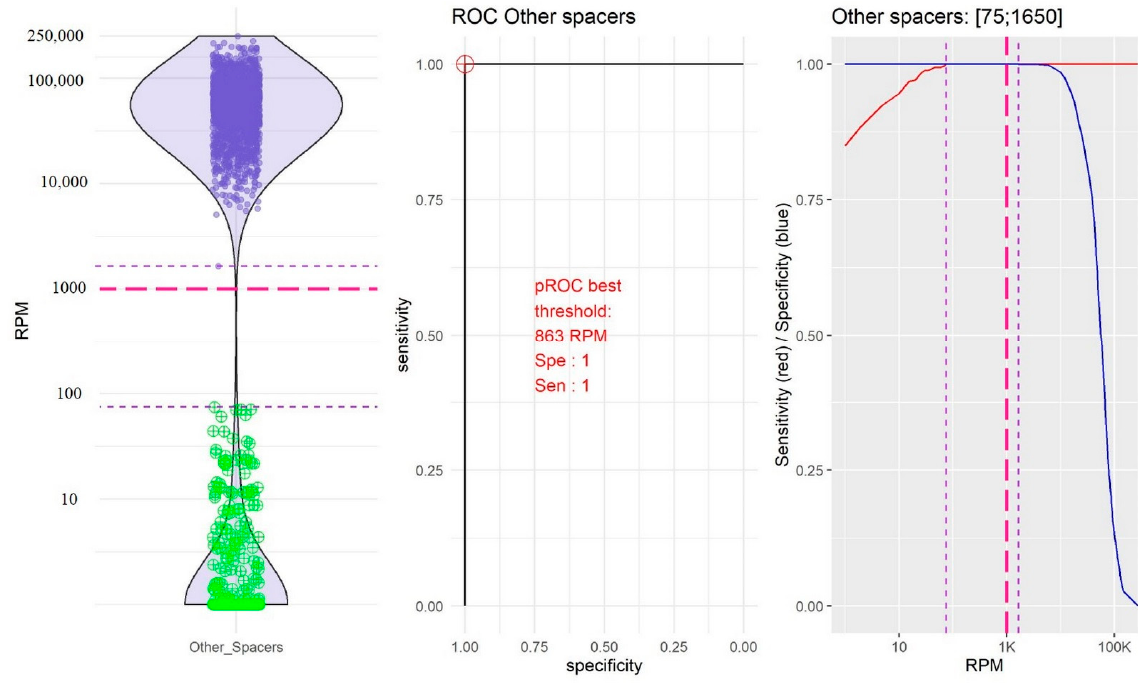
Figure 3. Determination of the reads per million (RPM) threshold for spacers 20, 21, and 31. On the left: Distribution in the form of a violin plot of spacers 20, 21, and 31 RPM. Purple circles represent the “present” spacers according to the membrane-based spoligotyping. Green circles represent the “absent” spacers according to the membrane-based spoligotyping. Dotted red line: RPM threshold choice (20,000 RPM). In the middle: Receiver operating characteristic (ROC) curve for spacers 20, 21, and 31. Red circle represents the best RPM threshold. On the right: Sensibility (red line) and specificity (blue line) compared to the membrane-based spoligotyping according to the variable RPM threshold. Dotted purple line: RPM thresholds between which the sensitivity and the specificity are maximized. Dotted red line: RPM threshold choice (20,000 RPM).